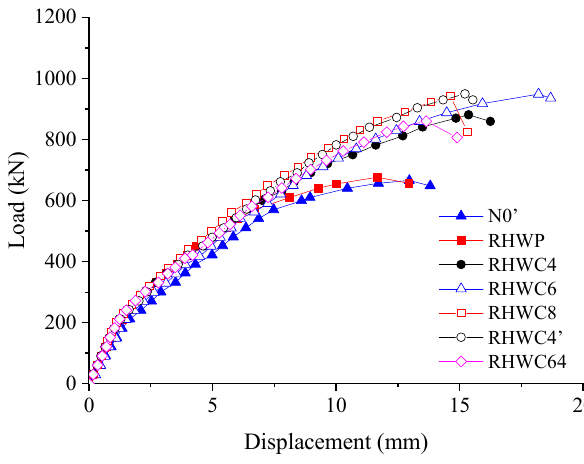
Figure 10. Load–deflection ( P– δ ) responses of Series B.